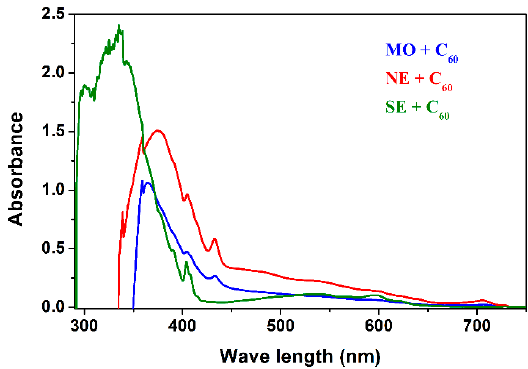
Figure 3. UV-VIS spectra of dielectric liquids modified by fullerene C 60 .